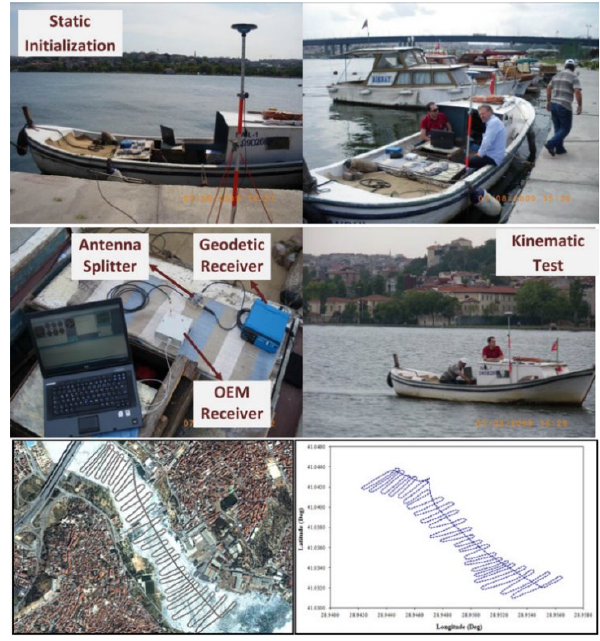
Figure 9. Photos from the study area and vessel’s route [11]. Guo et al. (2014) [12] estimated, for the first time, the SSHs following a complex procedure which involved the joint use of a GNSS on a boat and a ship-borne gravimeter. The ship gravimeter and the GNSS measured anomalies in gravity and SSHs along the ship’s track, respectively. The new method was applied on the coastal sea of the Shandong Peninsula in China. Deflections of the vertical (DOVs) on the ship were estimated from the measured gravities using the least squares co-location method. This work provided an original method connecting the height anomaly difference with DOVs, gravity and geodetic data. The precision of the DOV along the ship track was better than 1, whereas the precision of ship-borne SSHs was better than 5 cm and those of the SSHs differences better than 3.5